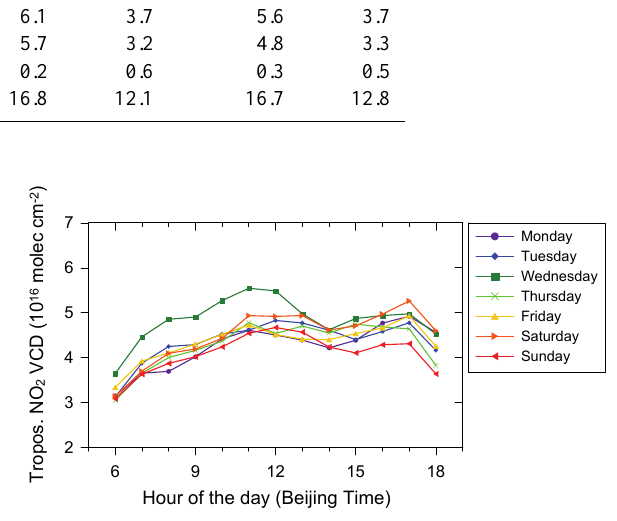
Fig. 9. Diurnal variations of the tropospheric NO 2 VCD for differ- ent days of the week, averaged over the period of August 2008 to September 2011.